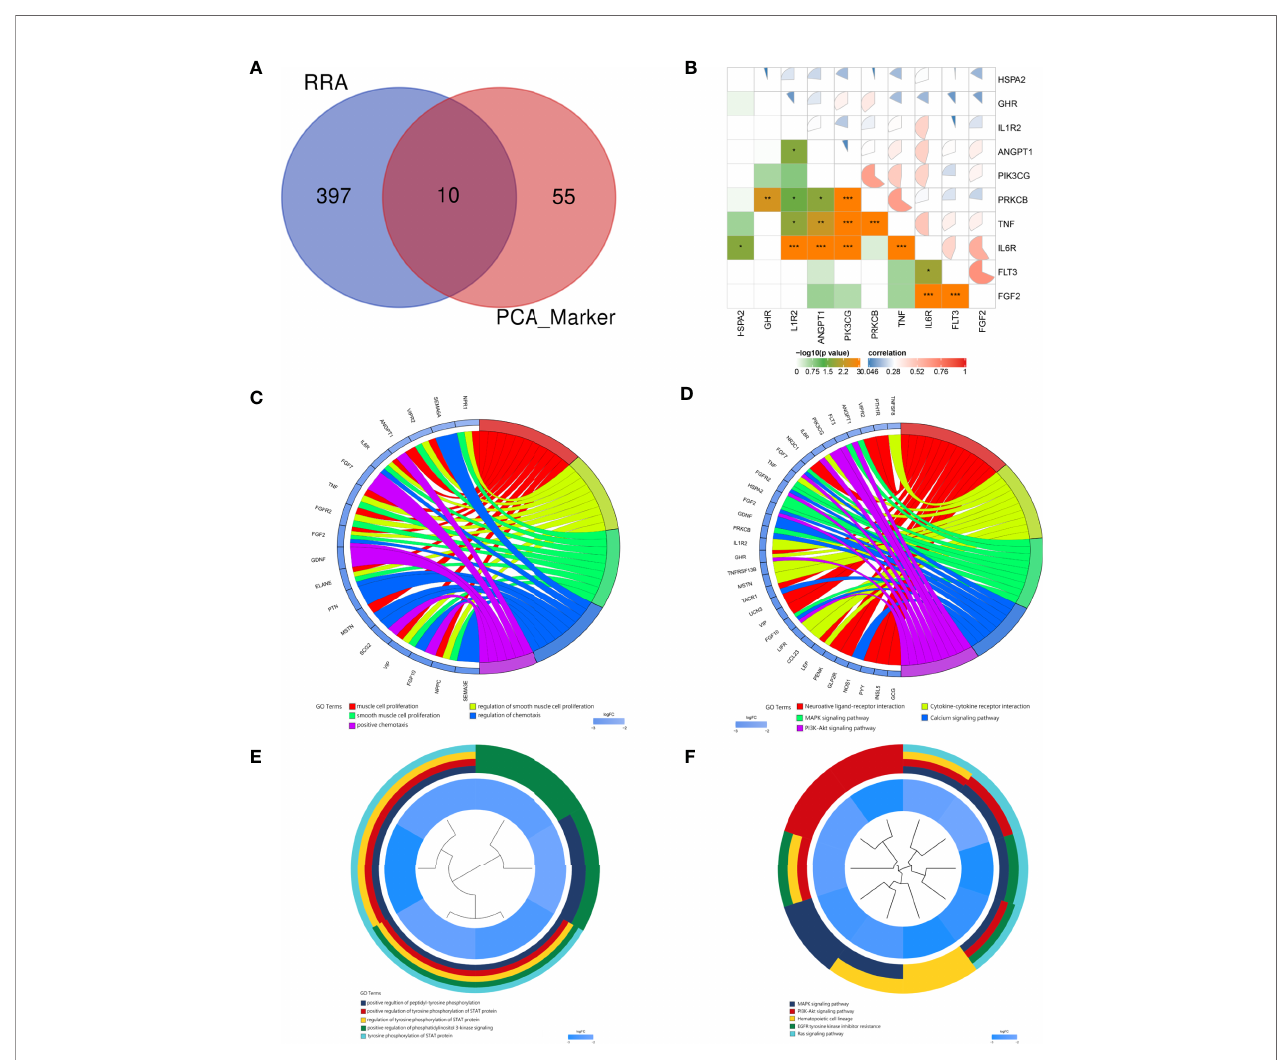
FIGURE 5 | Identi fi cation and correlation of hub immune-related DEGs. GO and KEGG analyses of the markers and hub immune-related DEGs. (A) Venn diagram of hub immune-related DEGs. Blue indicates RRA of the three datasets obtained from the GEO database. Red indicates markers identi fi ed by PCA. (B) Correlations of hub immune-related DEGs. (C) Circ plot indicating the top fi ve GO enrichment terms of markers. (D) Circ plot indicating the top fi ve KEGG pathway terms of markers. (E) Cluster plot showing the top fi ve GO enrichment terms of hub immune-related DEGs. (F) Cluster plot showing the top fi ve KEGG pathway terms of hub immune-related